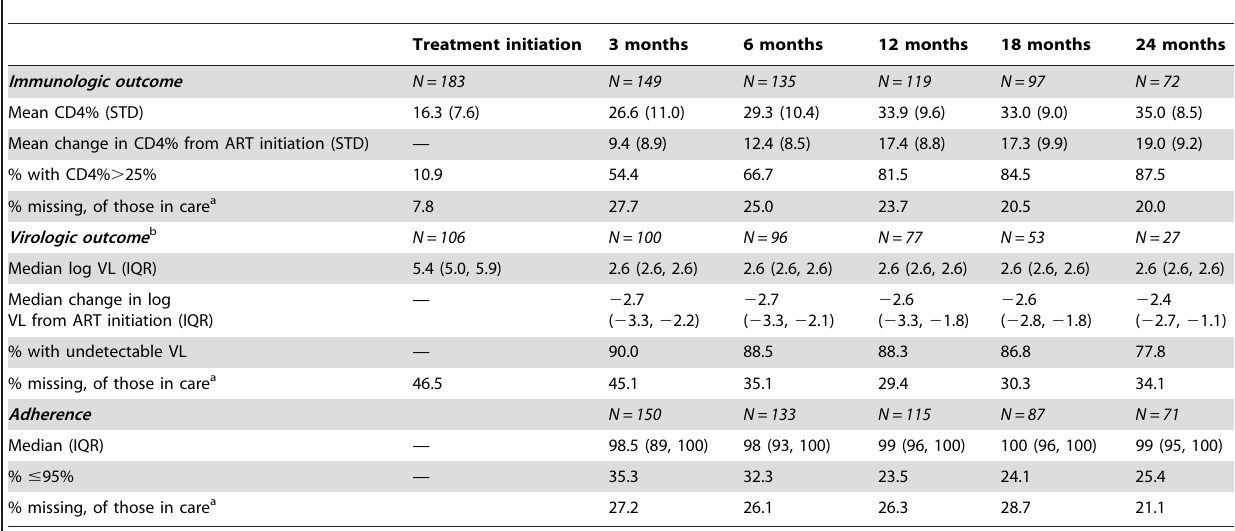
Table 3. Immunologic and virologic outcomes and adherence by time on treatment.